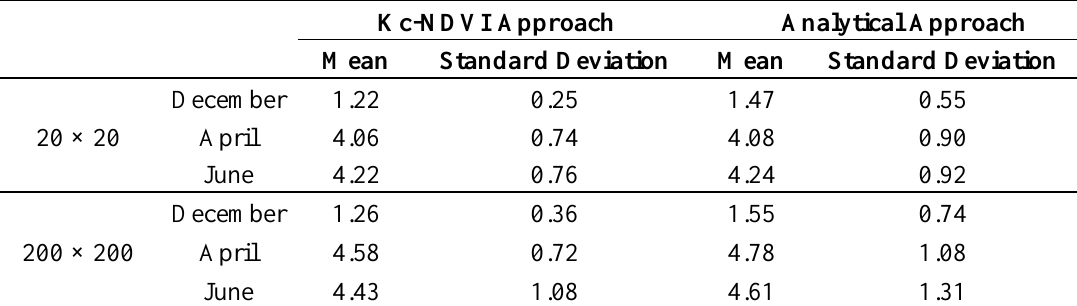
values at different spatial c